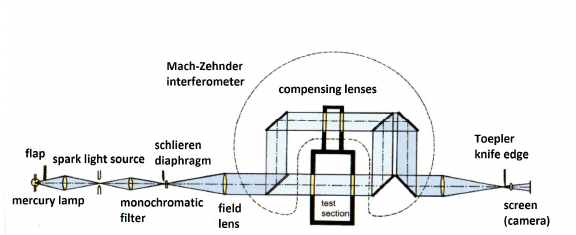
Fig. 1. The scheme of the optical measurements using Mach- Zehnder